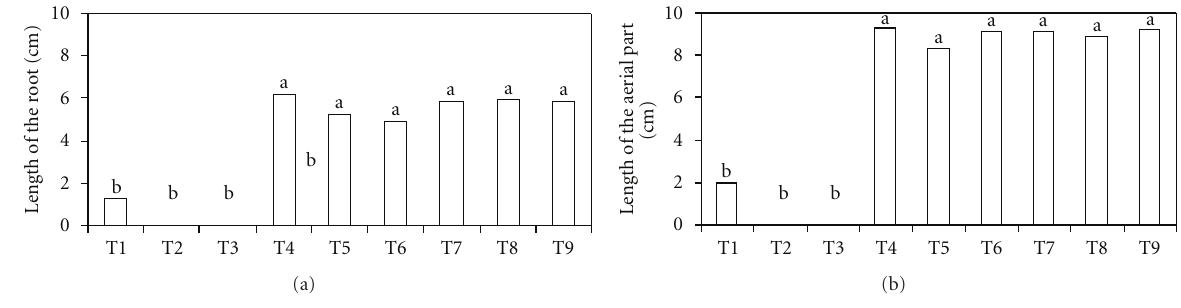
Figure 3: Root (a) and aerial part (b) lengths of Ormosia arborea seedlings submitted to di ff erent dormancy breaking treatments. T 1 : Control; T 2 : immersion in 100 ◦ C water; T 3 : immersion in boiling water followed by 24 h of soaking; T 4 and T 5 : scarification with number 100 and number 50 sandpaper, respectively; T 6 , T 7 , T 8 , and T 9 : immersion in sulfuric acid for 1 hour, 50min, 45min, and 30 min,